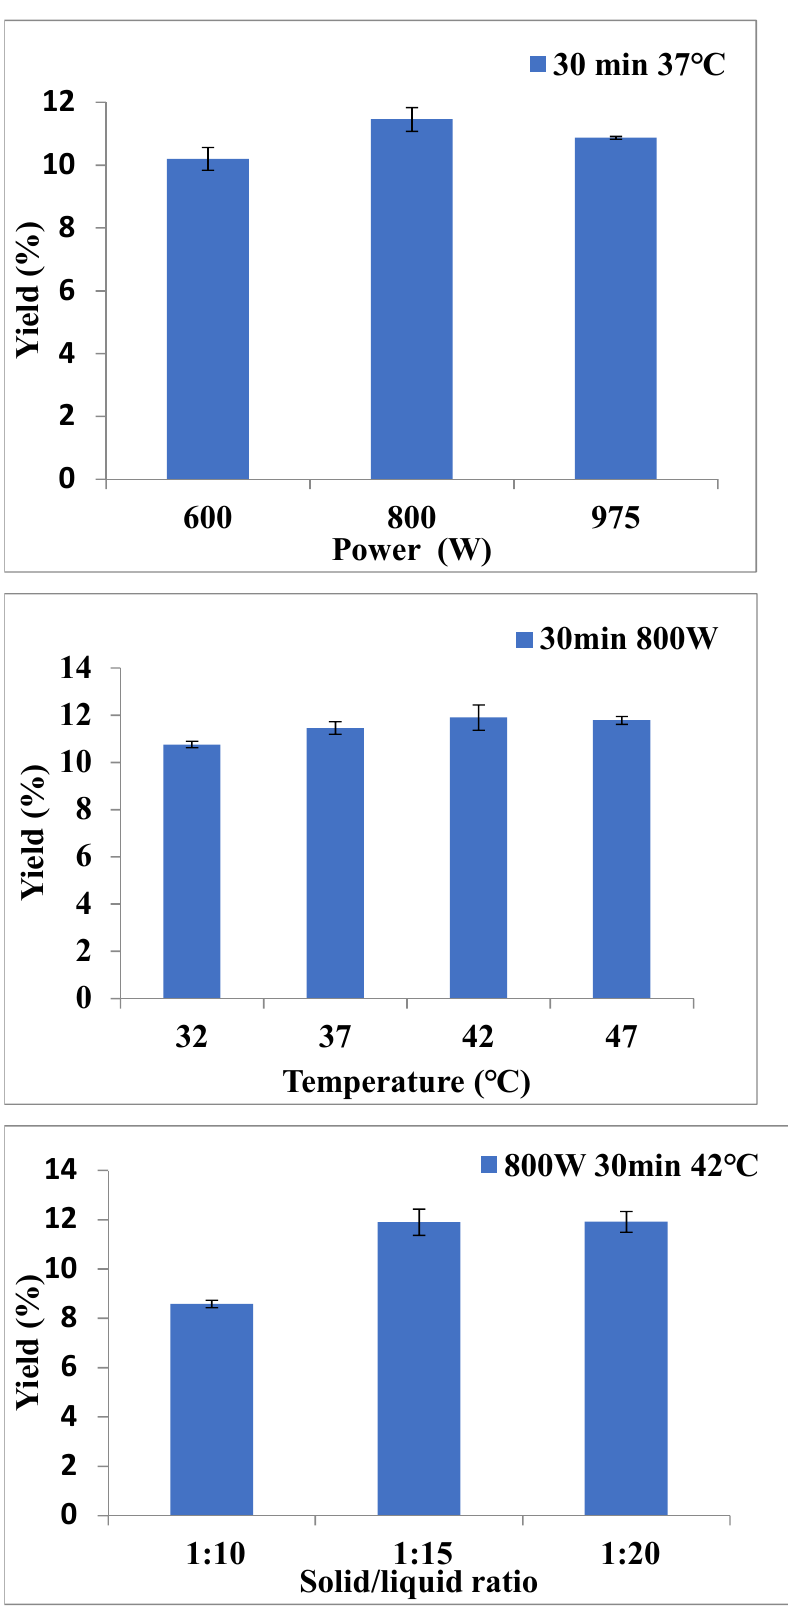
Figure 1. The yields of various parameters in the MAE; the maximal yield of extracts were at 800 W power, 30 min extract time, 42 °C operative temperature, and 1:15 solid/ethanol (g/mL) ratio.